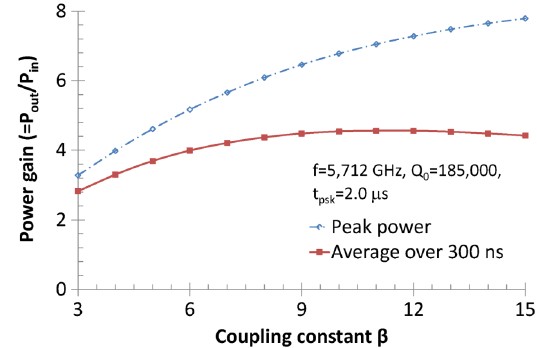
FIG. 7. Theoretical rf power gain as a function of the coupling constant of SLED. The structure gradient increases as the square root of the power gain averaged over 300 ns, the structure fill